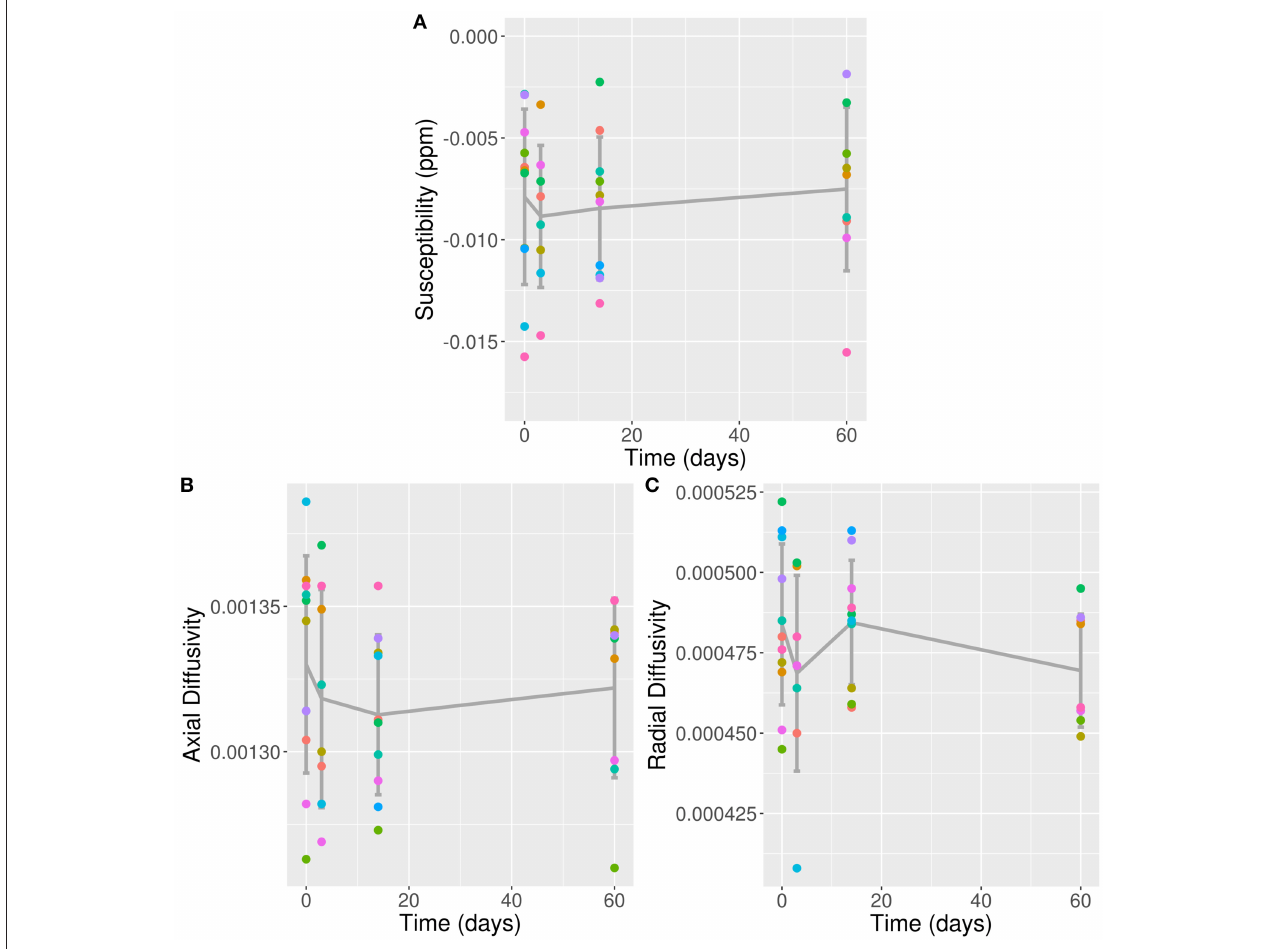
FIGURE 2 | QSM, AD, and RD Values in VOI Over Time. (A) QSM values (in ppm); (B) AD values; and (C) RD values plotted against time post-concussion by individual subjects separated by color, and mean and standard deviation (error bars) plotted in dark gray; against time post-con Note: time zero refers to baseline